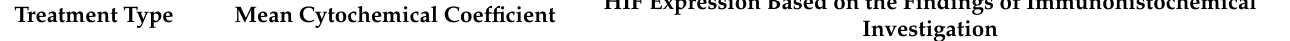
Table 1. The hypoxia-inducible factor (HIF) content in the organ of Corti structures when using different therapeutic and preventive regimens with the drug